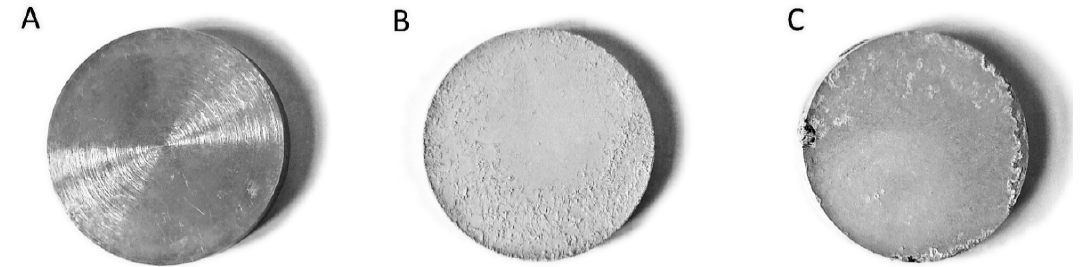
Figure 1. Stereo images of: ( A ) untreated sample; ( B ) sample PEO-Si; and ( C ) sample PEO-P.